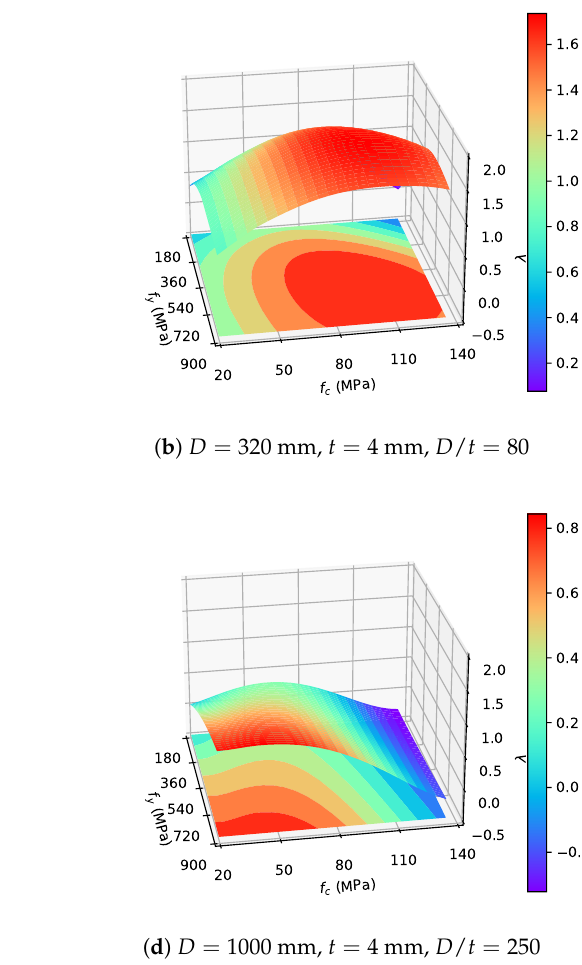
Figure 16. Variation in the composite ratio λ with different material strengths. For moderate D / t ratios ( D = 320 mm, t = 4 mm, and D / t = 80, as shown in Figure 16b, and D = 600 mm, t = 4 mm, and D / t = 150, as shown in Figure 16c),